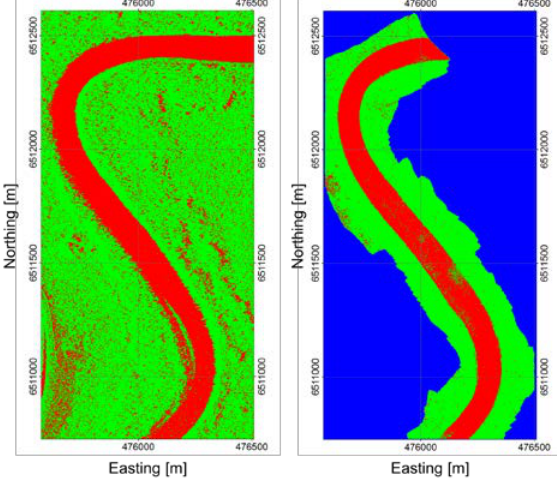
Figure 10. Output from the Maximum Likelihood supervised classification. Left: SAR image. Right: sUAS ortho-image mosaic. Green represents land, red represents water, blue represents